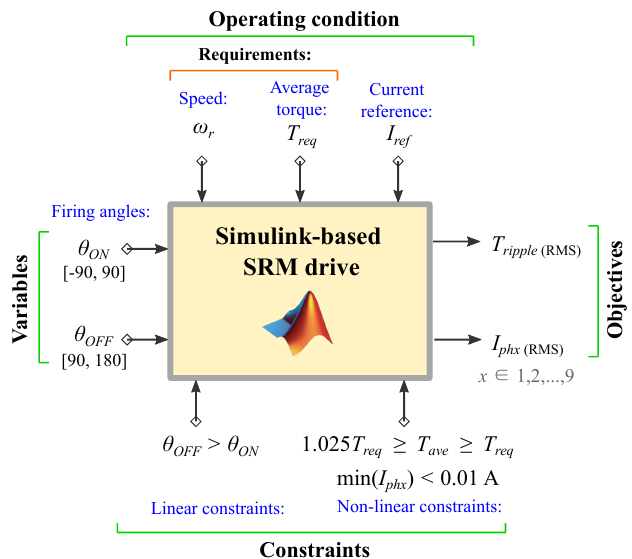
Figure 6. GA multiobjective